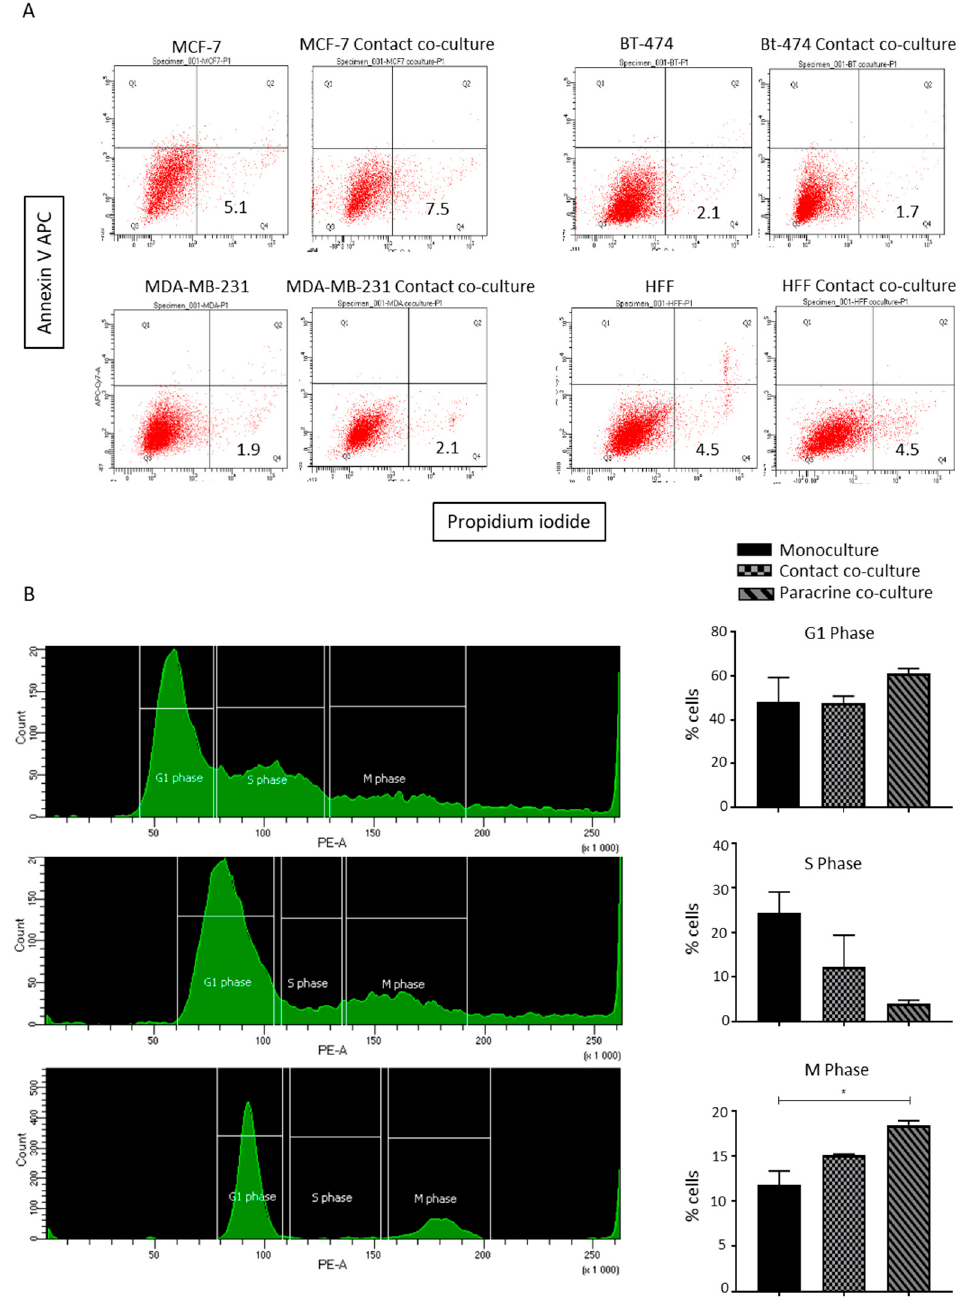
Figure 5. Lipoaspirate contact culture results in cell cycle arrest in MCF-7 cells. ( A ) Effect of lipo-aspirate contact co-culture on breast cancer cell survival. AnnexinV/Propidium Iodide staining was employed to estimate the cell death of breast cancer cells upon co-culture. ( B ) Cell cycle analyses of paracrine and contact-co-cultured MCF-7 cells with lipo-aspirates. Graphs show the percentages of cells in different phases of cells upon different culture conditions. p value < 0.05 = *.